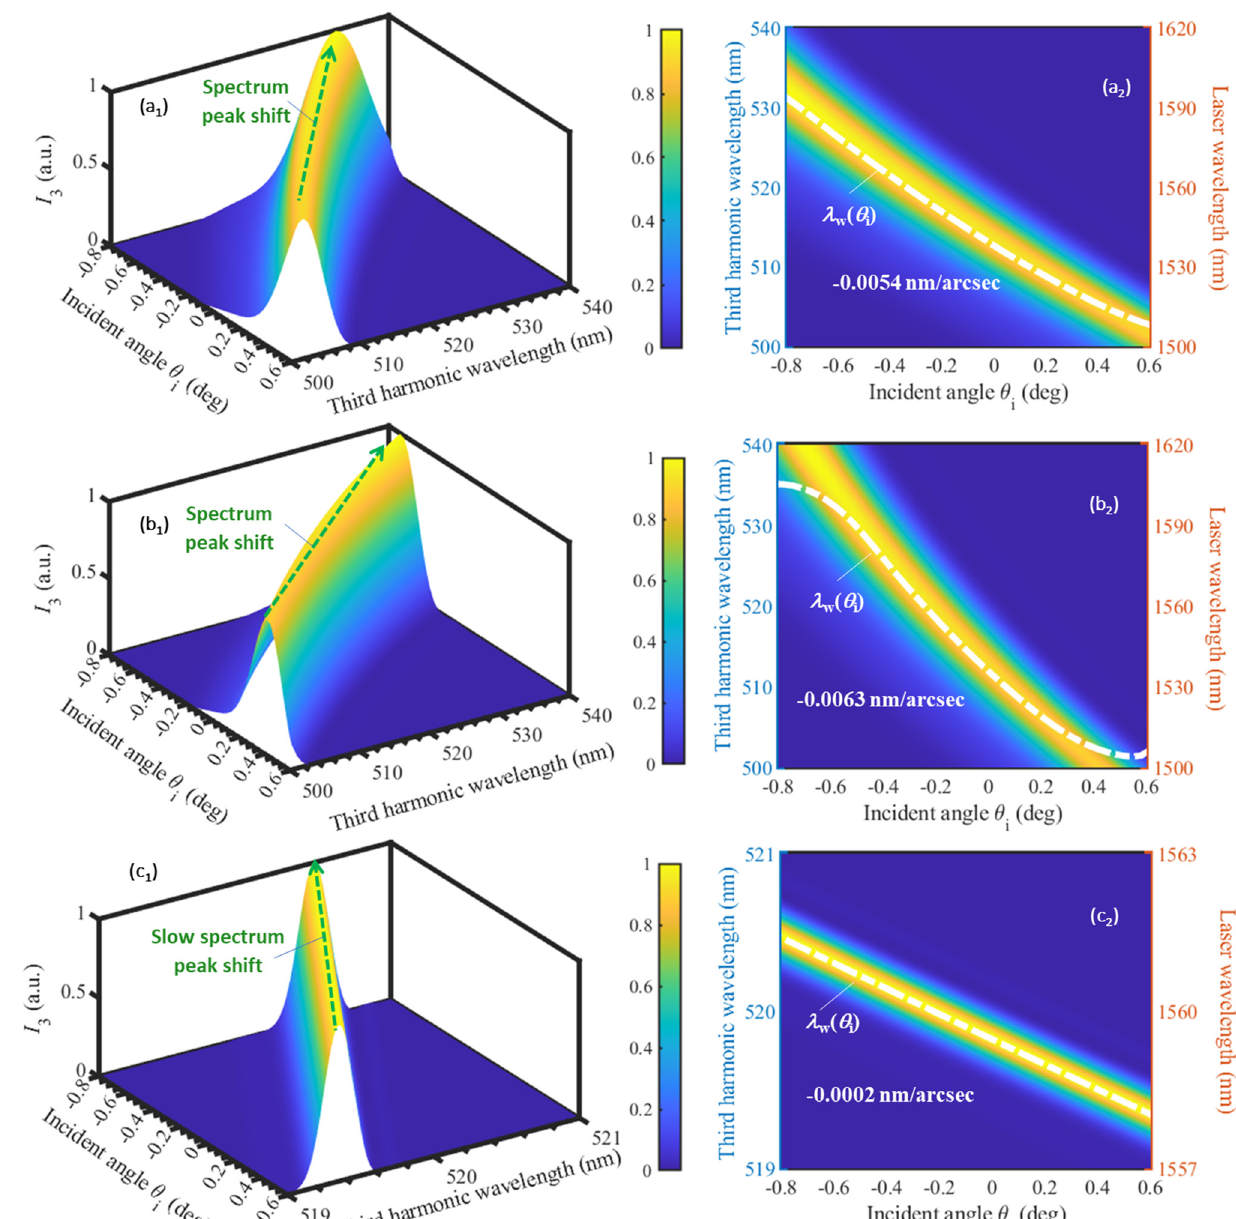
Figure 8. ( a 1 , b 1 , c 1 ) The 3-D plot I 3 ; ( a 2 , b 2 , c 2 ) The 2-D plot I 3 . The letters a, b, and c correspond to the materials of α -BBO, calcite, and rutile in order. The green dotted arrows show the spectrum peak shifts in frequency domain. The white dotted lines denote the weighted wavelength λ w ( θ i ).